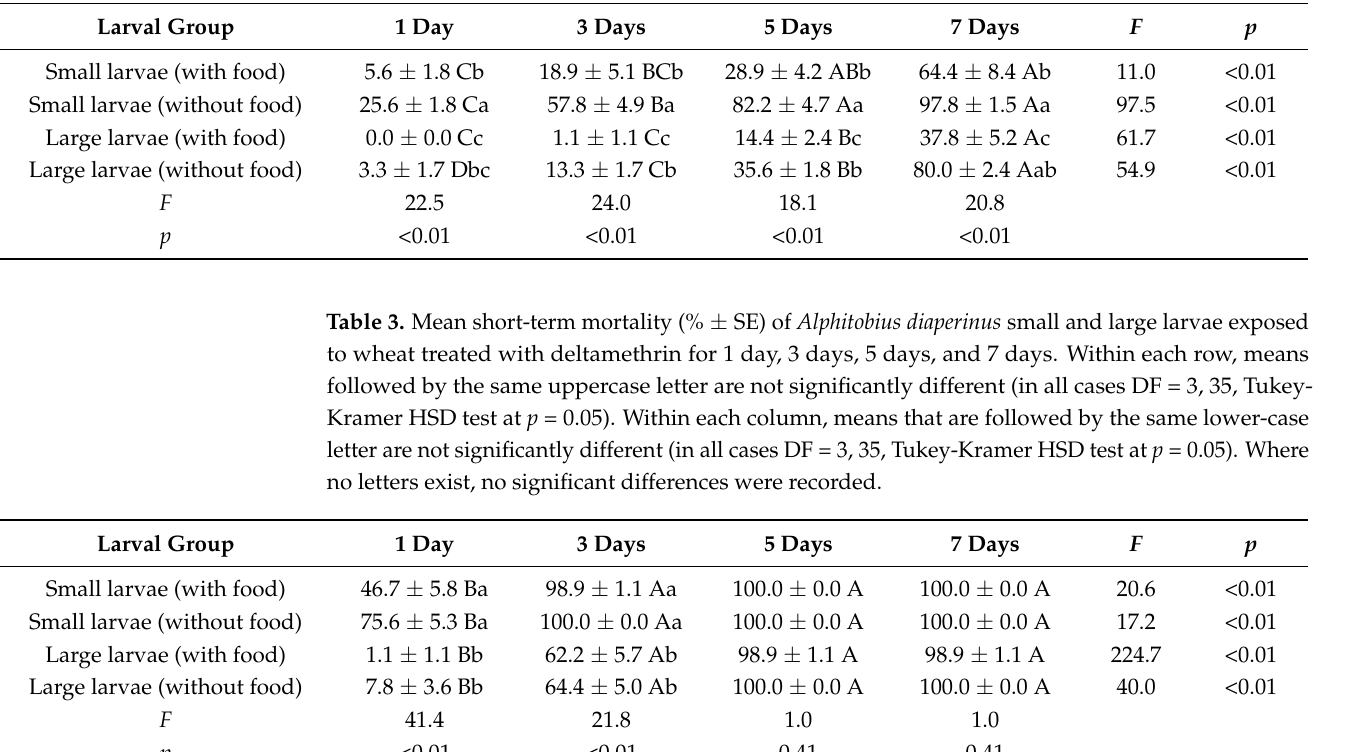
Table 2. Mean short-term mortality (% ± SE) of Alphitobius diaperinus small and large larvae exposed to concrete treated with etofenprox for 1 day, 3 days, 5 days, and 7 days. Within each row, means followed by the same uppercase letter are not significantly different (in all cases DF = 3, 35, Tukey- Kramer HSD test at p = 0.05). Within each column, means that are followed by the same lower-case letter are not significantly different (in all cases DF = 3, 35, Tukey-Kramer HSD test at p = 0.05).